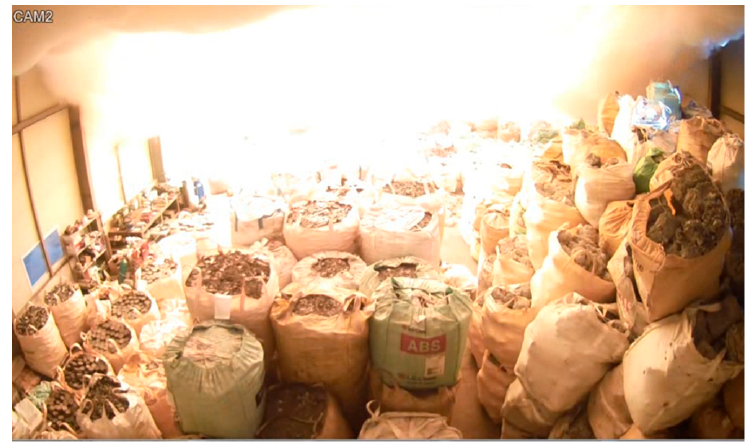
Figure 1. Dust explosion in a magnesium recycling plant (2016) (Photo by Miryang fire department).